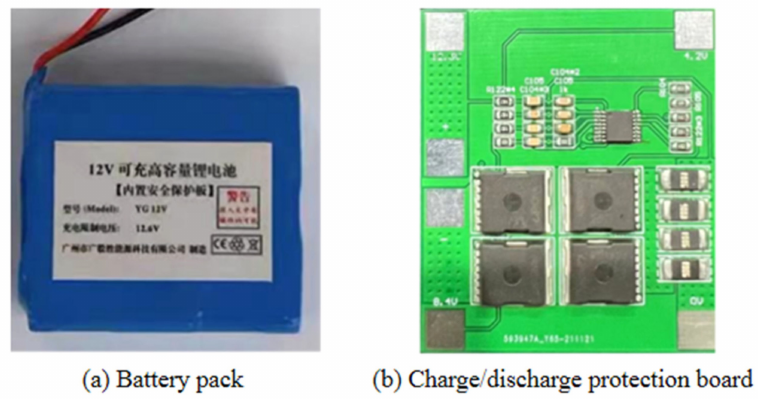
Figure 19. Battery packs and protection board.